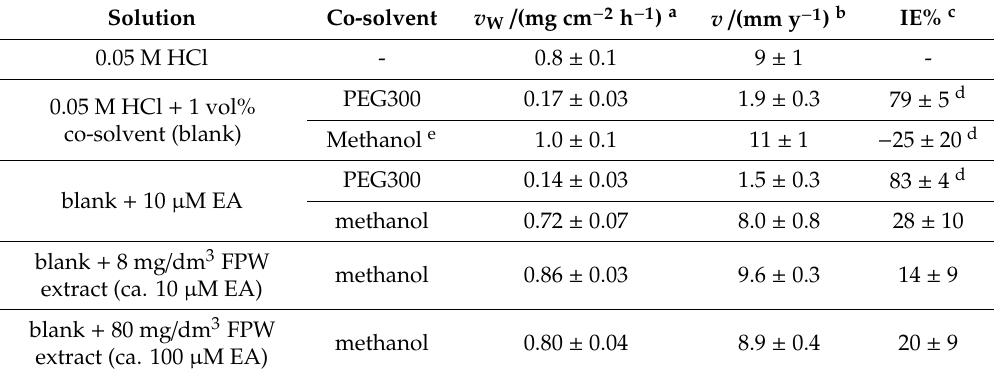
Table 1. Results of the corrosion tests (by mass loss determination, at least in triplicates) carried out by dipping iron coupons for 1 h at 30 ◦ C in uninhibited and inhibited 0.05 M HCl solutions. Pure ellagic acid and FPW extract were considered as